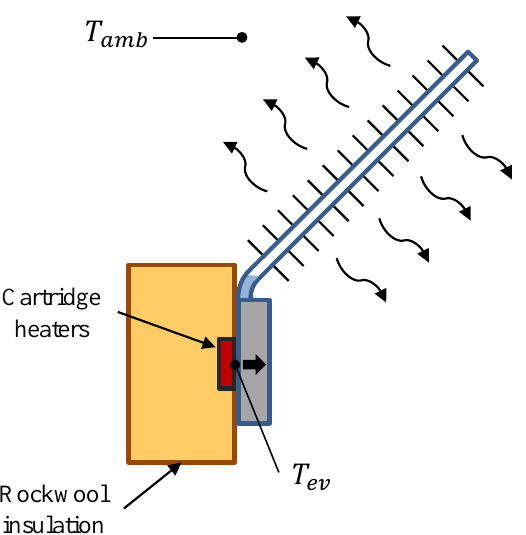
Figure 3. Schematics of the characterization of the cold side heat